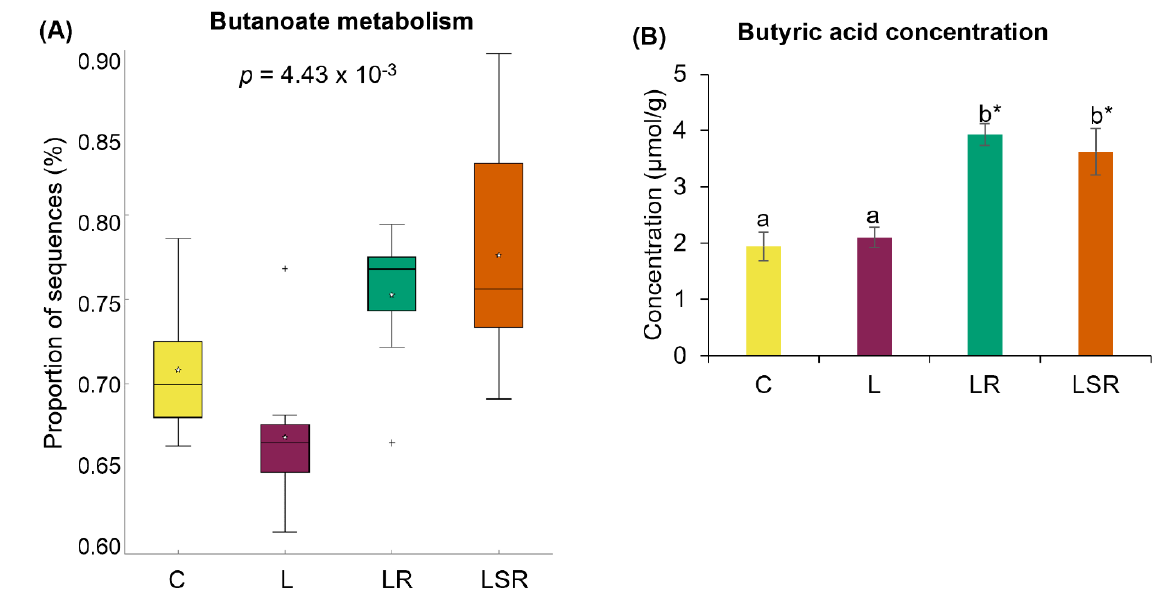
Figure 8. Analyses of SCFAs. ( A ) Relative abundance of microbial functional pathway responsible for butanoate metabolism. This analysis was performed by evaluating the differences in the function of the microbial communities ascertained from 16S rRNA sequencing using PICRUSt software. ( B ) Butyric acid concentration. Concentrations of the SCFAs were measured using the cecal content samples. Supplementary Figure S5 shows the concentrations of acetic acid and propionic acid. All the values are expressed as the mean ± S.E. Statistical analysis was conducted by one-way ANOVA followed by Dunnett’s test for multiple comparison analysis. Statistical analysis of bacterial sequences was conducted by Kruskal–Wallis test followed by Tukey – Kramer test for multiple comparison analysis. Statistical analysis of other parameters was conducted by one-way ANOVA followed by Dunnett’s test for multiple comparison analysis. a, b represent p < 0.05 compared to the C group, * represent p < 0.05 compared to the L group.